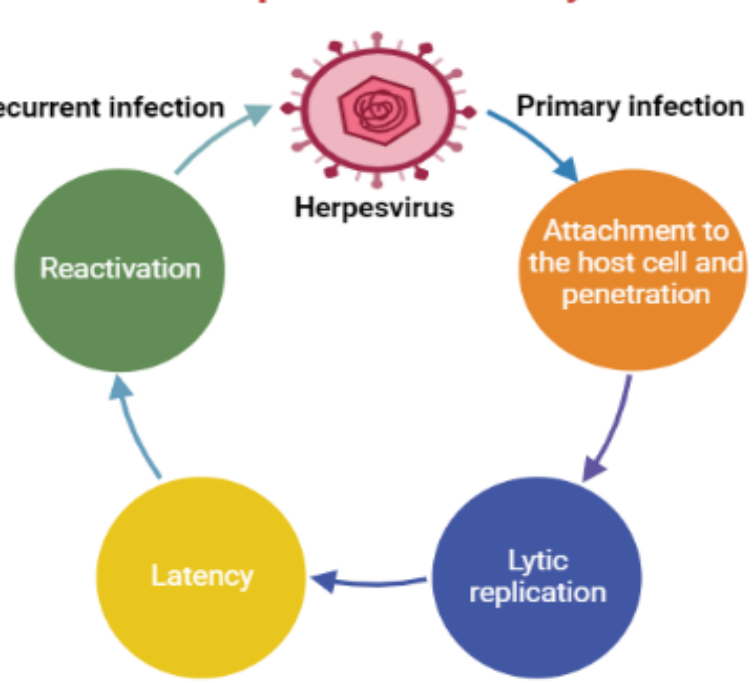
Figure 1. An illustration displays an overview of the herpesvirus life